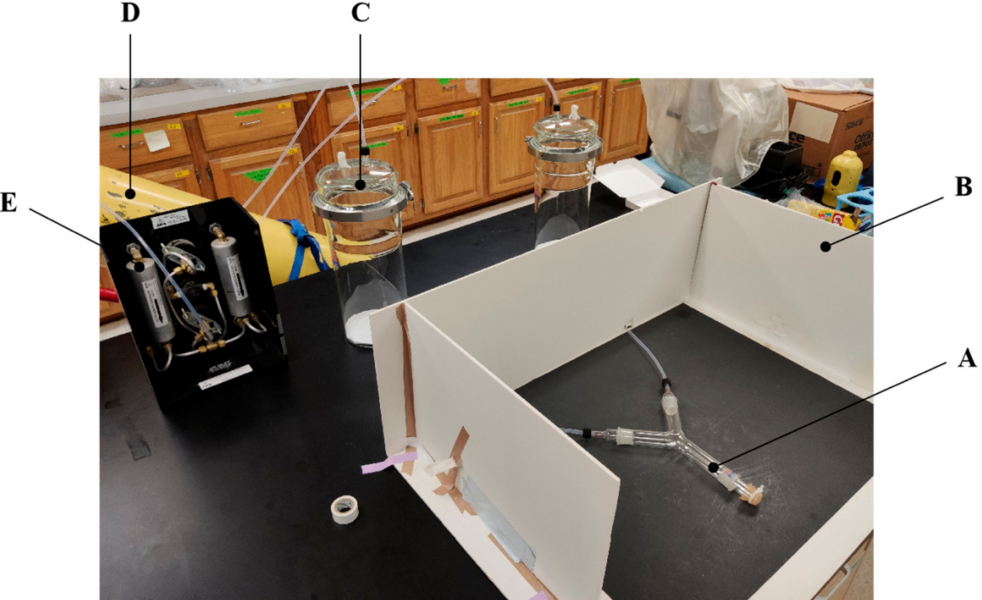
Figure 1. The Y-tube olfactometer for observing the mate search behavior in the sweetpotato weevil (SPW). (A) Y-shaped glass tube; (B) The wall used to prevent male SPW from being influenced by external factors; (C) Odor sources jar; (D) Clean air gasholder; (E)